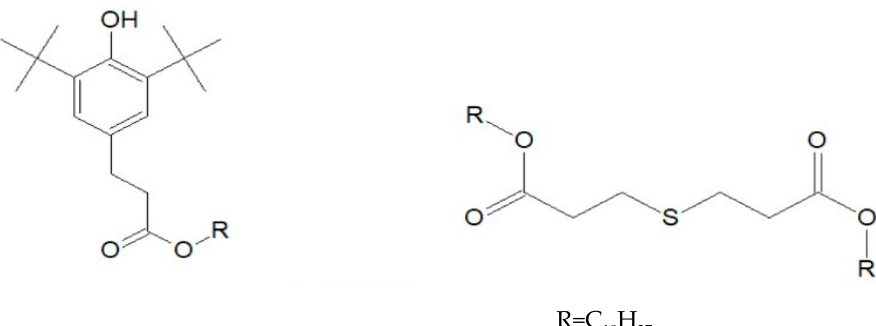
Figure 1. Chemical structure of Irganox 1076 ( left ) and Irganox PS802 ( right ) additives.